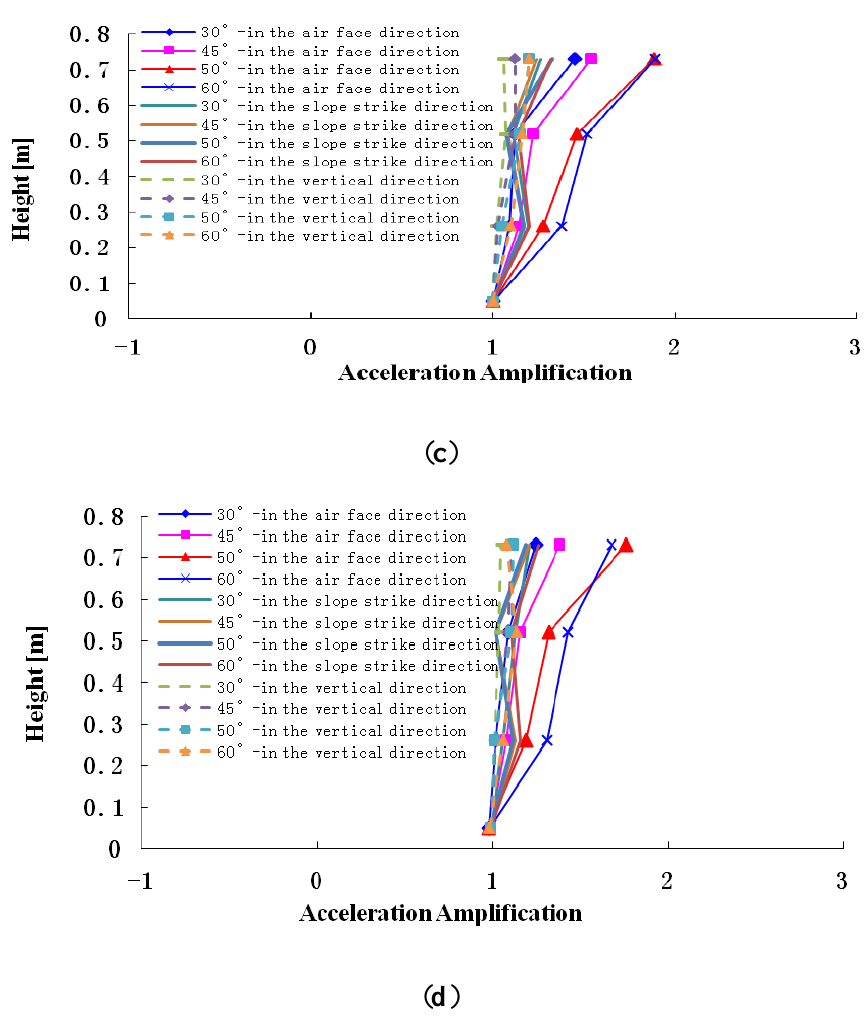
Figure 16. Peak acceleration amplification coefficient in the different directions subjected to different intensity earthquakes. (a) Acceleration amplifications in different slope angles and different directions when the input PGA = 0.1 g. (b) Acceleration amplifications in different slope angles and different directions when the input PGA = 0.2 g. (c) Acceleration amplifications in different slope angles and different directions when the input PGA = 0.4 g; (d) Acceleration amplifications in different slope angles and different directions when the input PGA = 0.7